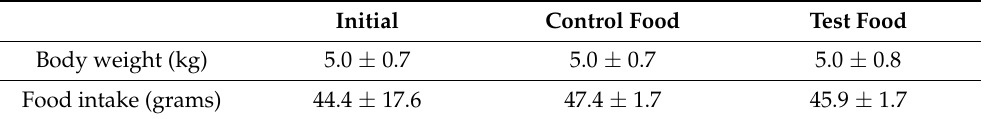
Table 3. Body weight and food intake at the end of the 28-day pre-feeding period (Initial) and after consuming control or test food for 28